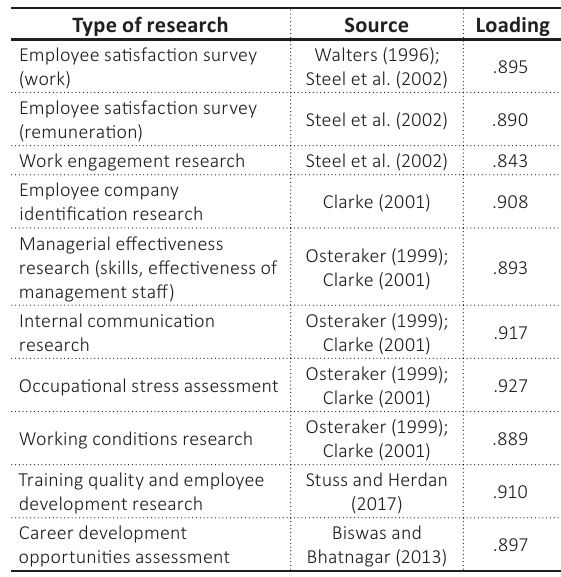
Table 2. Examples of intra-organizational research by areas of